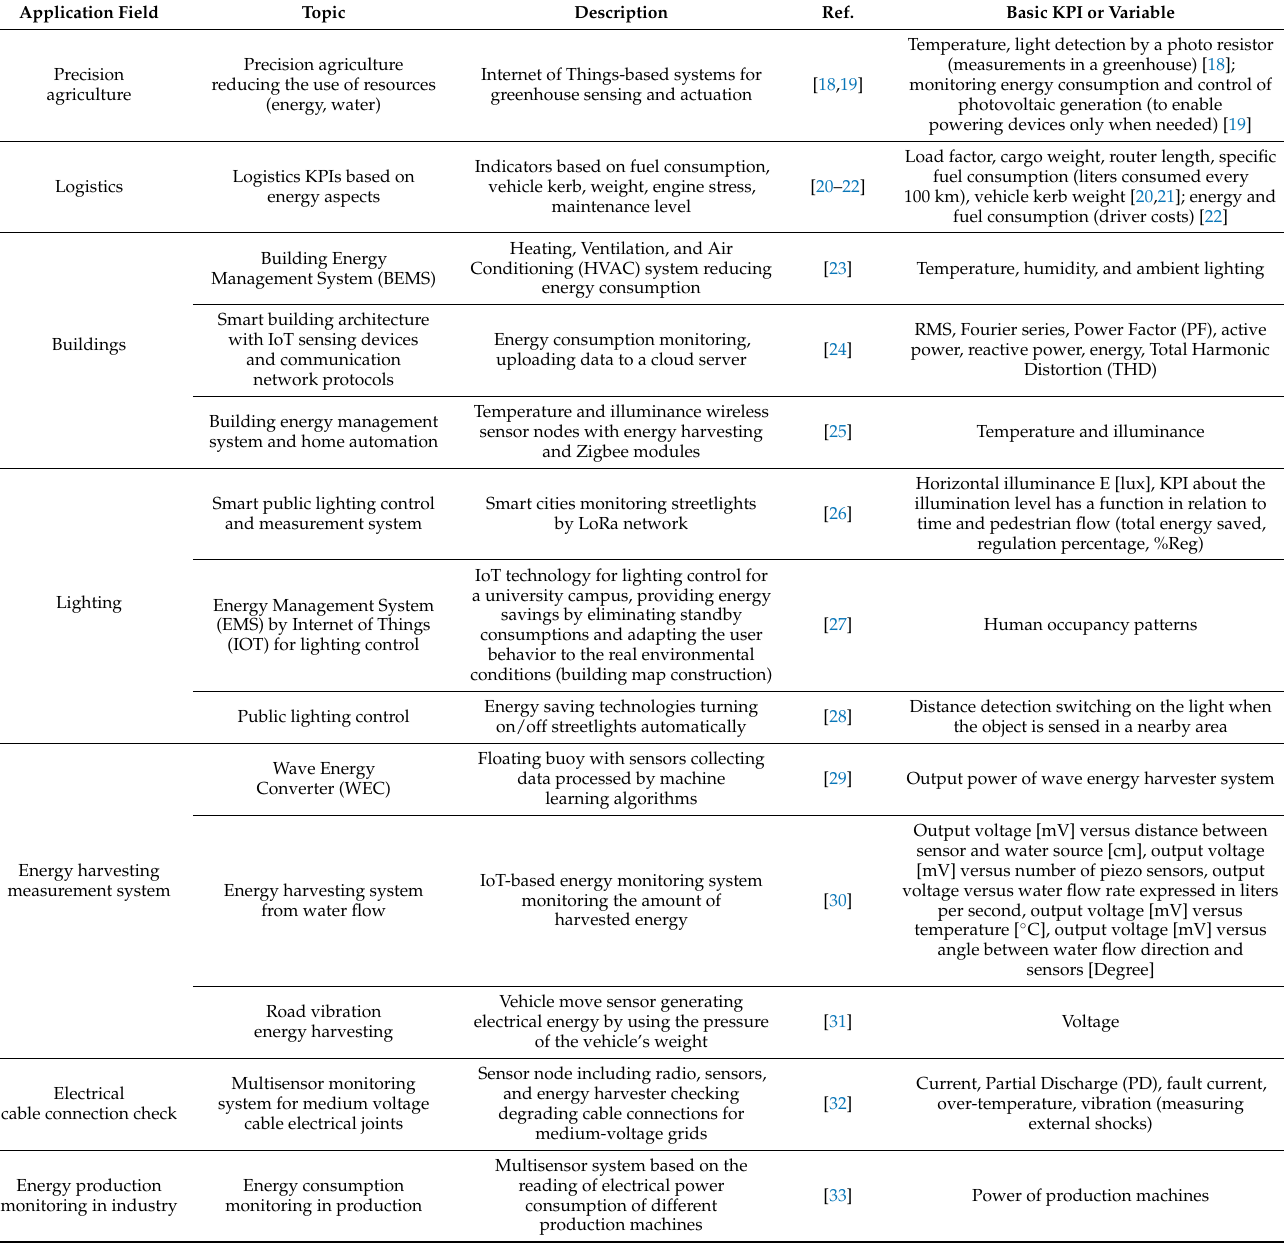
Table 2. State of the art: application fields of energy